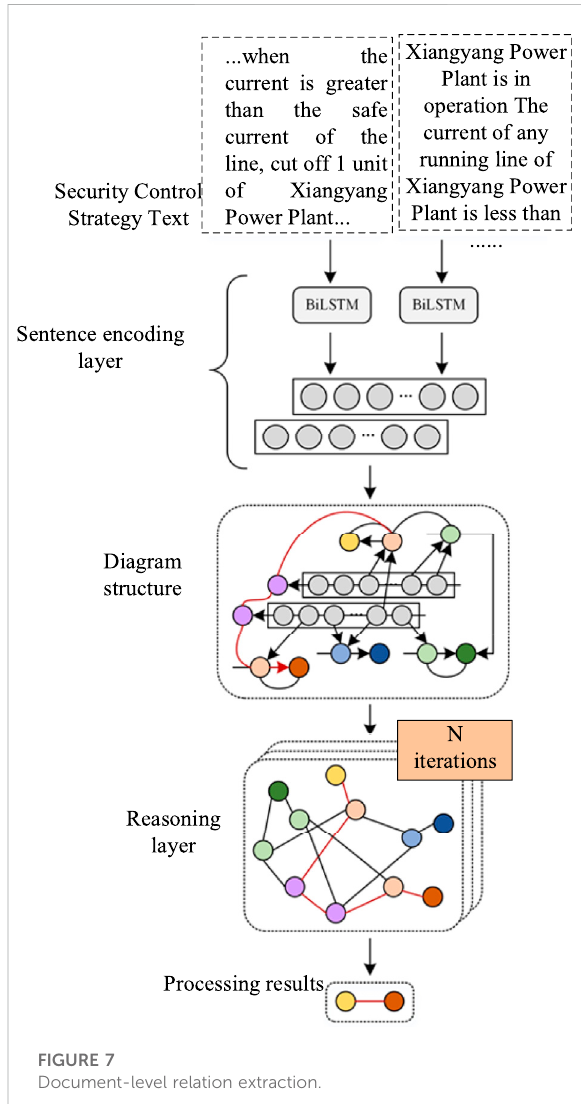
FIGURE 7 Document-level relation extraction.